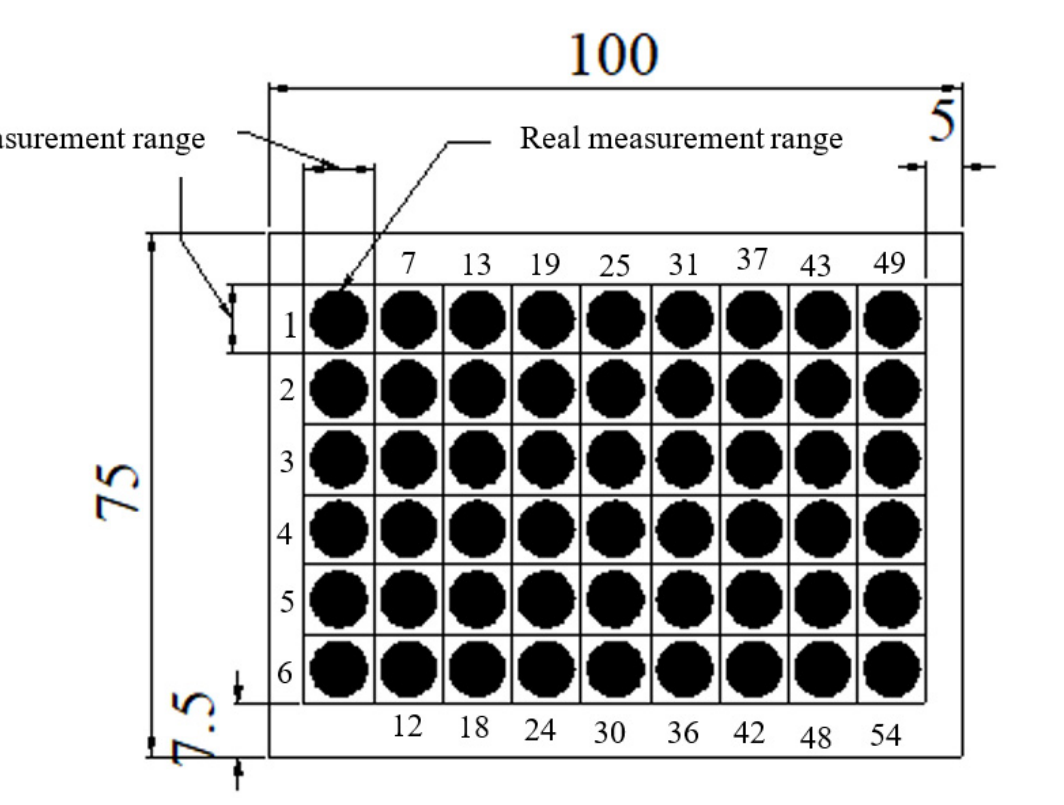
Figure 4. Measurement points of molded light guide plate. (unit = mm).